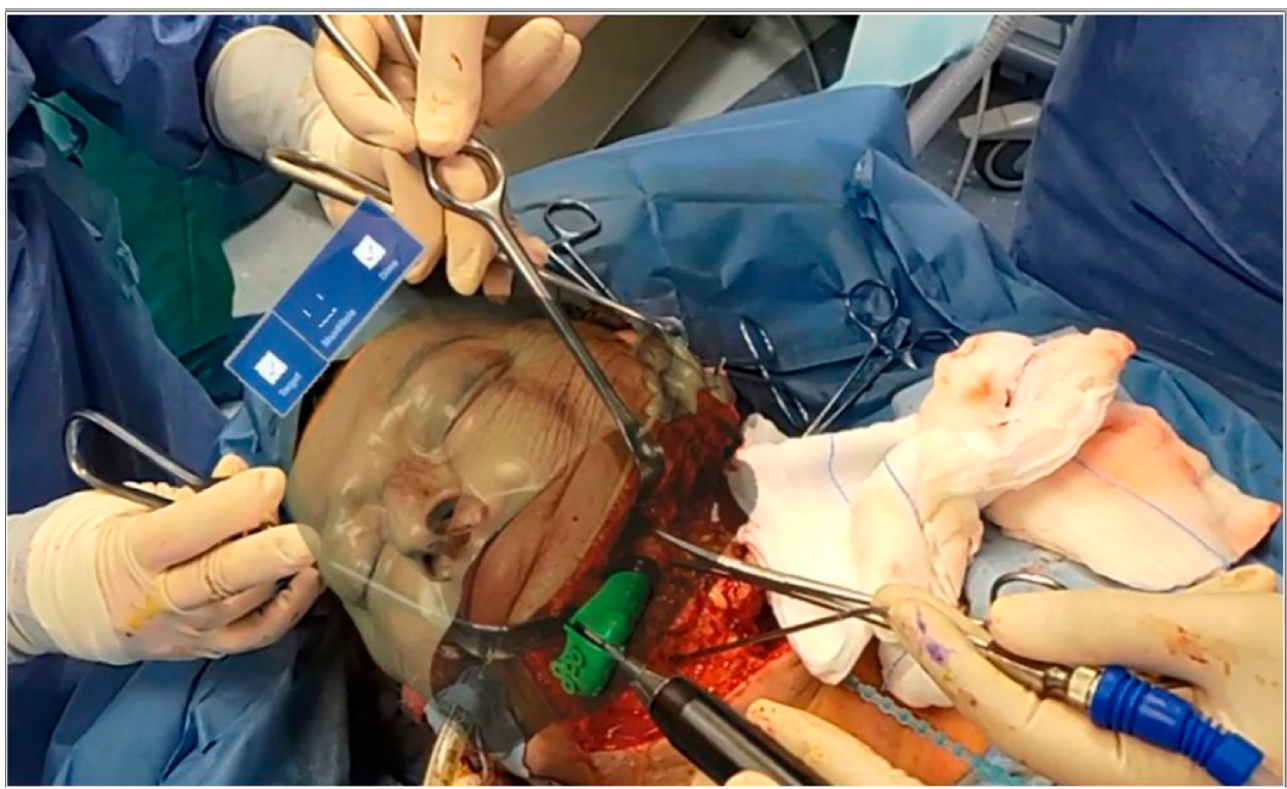
Figure 5. Osteotomies were performed according to the VSP visualized during the surgical act. Once the osteotomy lines were drawn, the custom cutting guides were used for treating the patient. The cutting guides were useful also to evaluate any error in the previously drawn corticotomy line under AR